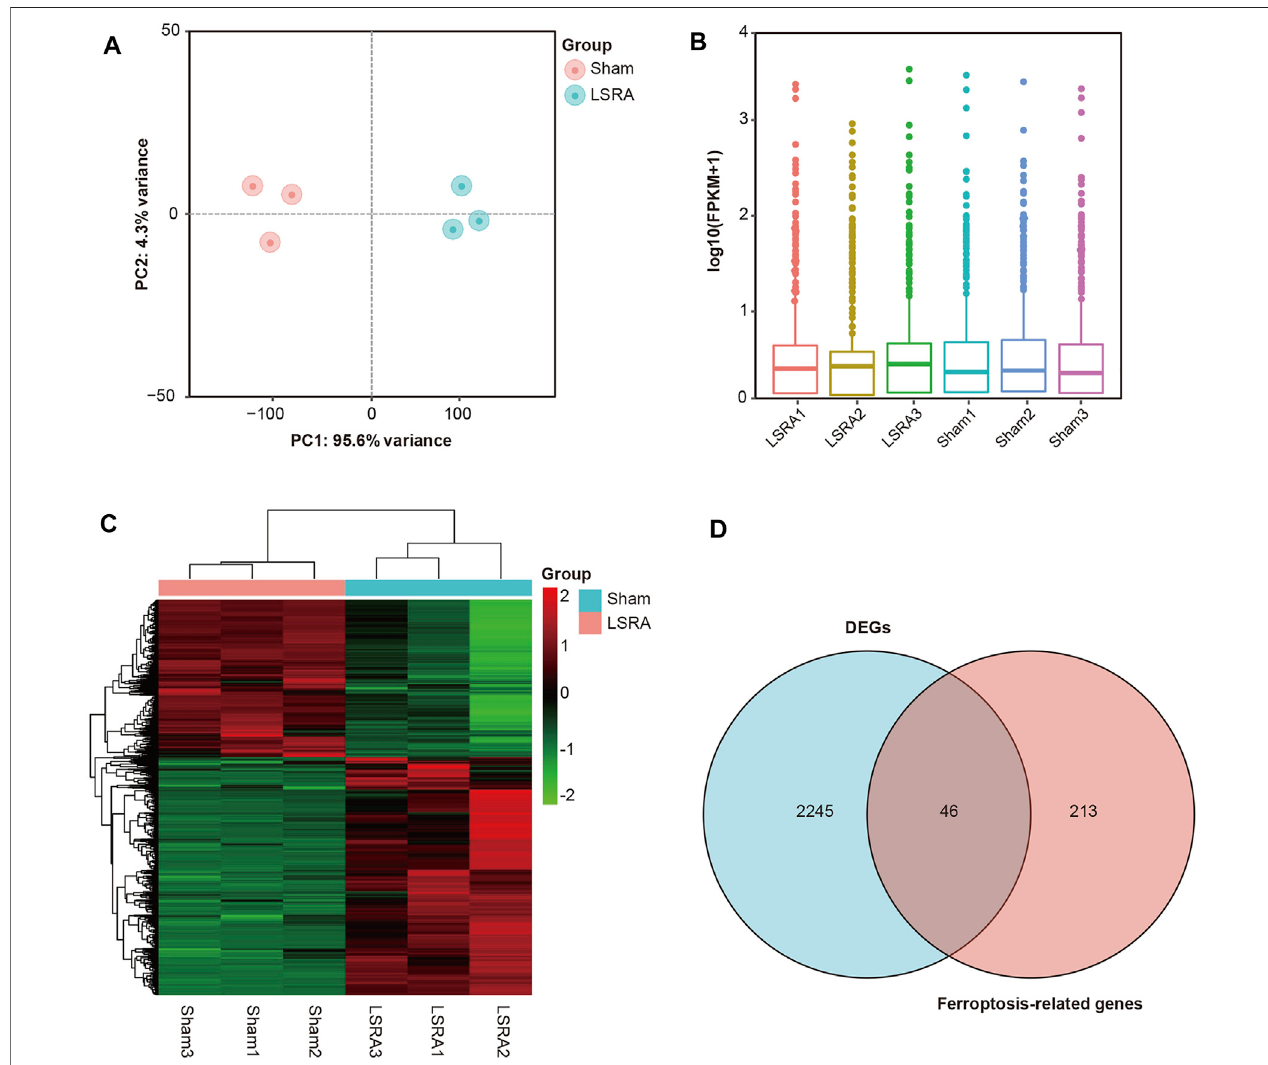
FIGURE 2 | Identi fi cation of DEGs and ferroptosis DEGs in spinal cord tissue after LSRA. (A) Principle component analysis showing distinct clustering of the individual samples of the Sham and LSRA groups. (B) Box plot showing that distributions of the mRNA expression pro fi les in all samples were nearly the same. (C) The heatmapshowshierarchicalclusteringofDEGsinspinalcordtissuebetweentheLSRAandsham-operatedrats. (D) VenndiagramofferroptosisDEGsinthespinalcord after LSRA. Abbreviations: DEGs, differentially expressed genes and LSRA, lumbosacral spinal root avulsion.